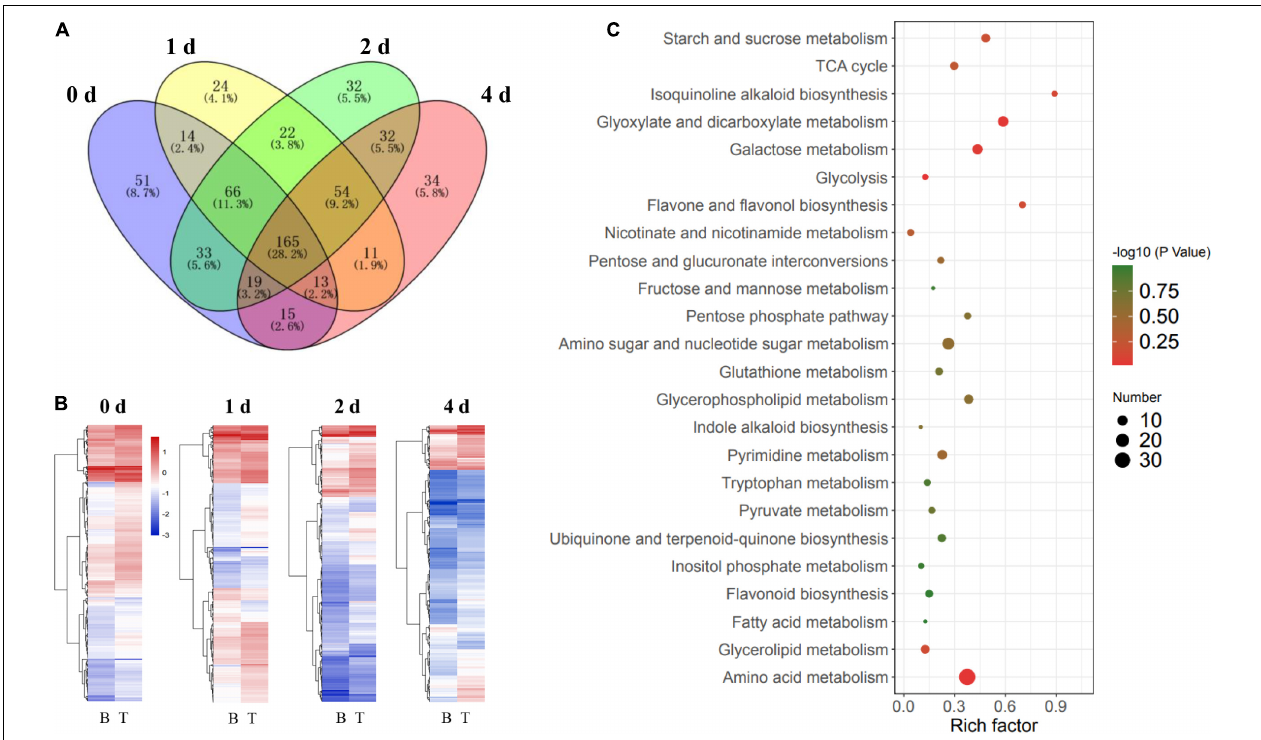
FIGURE 5 | Comparative analysis of metabolites in the in vitro dodder shoots at different stages. (A) Venn diagram analysis on the time-specific (days 0, 1, 2, and 4) DMs between the basal stems and shoot tips. A total of 165 DMs were shared among four comparison groups. (B) The clustering heatmap of DMs in B vs. T on days 0, 1, 2, and 4, respectively (B, basal stems; T, shoot tips). (C) Scatter plot of main enrichment KEGG pathways statistics for DMs among four groups. The color and size of the dots represent the range of the –log10 ( P -value) and the number of DMs mapped to the indicated pathways, respectively.